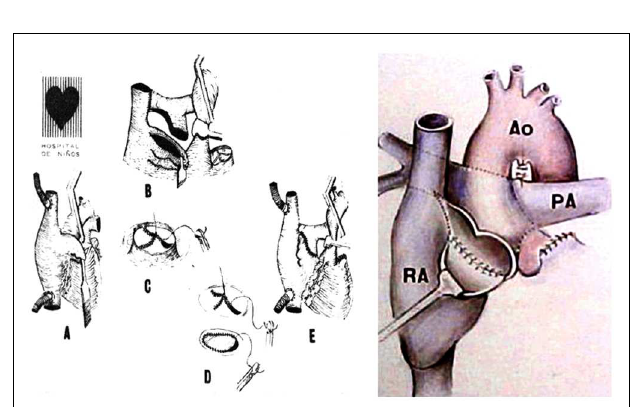
FIGURE 3 | Illustrations demonstrate the steps of the technique used for the posteriorAPA developed in 1978 presented in London, 1980